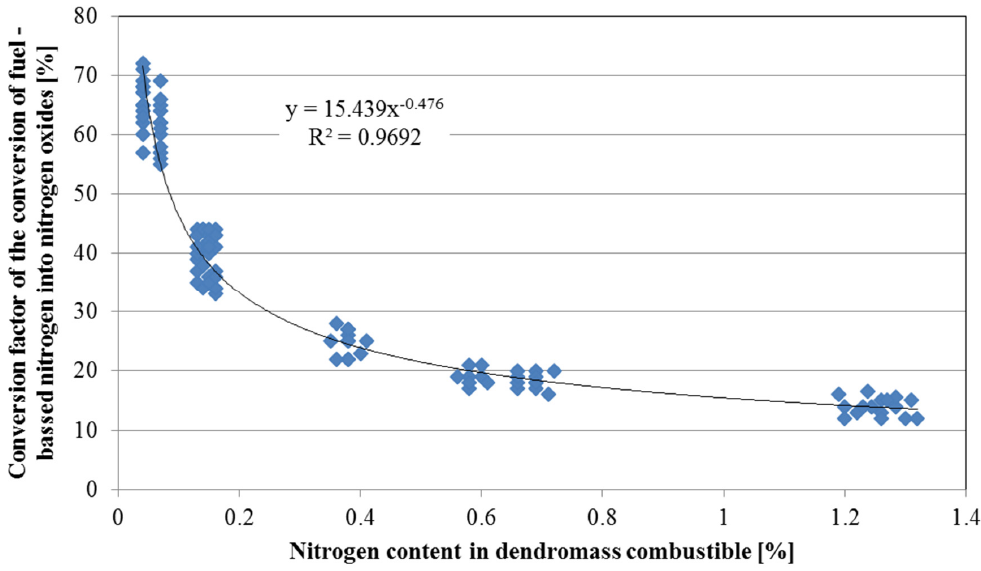
Figure 1. Dependence of the conversion factor of fuel-bound nitrogen into nitrogen oxide emissions on the content of nitrogen in dendromass in the process of combustion of moist dendromass in grate furnaces of heat generators.